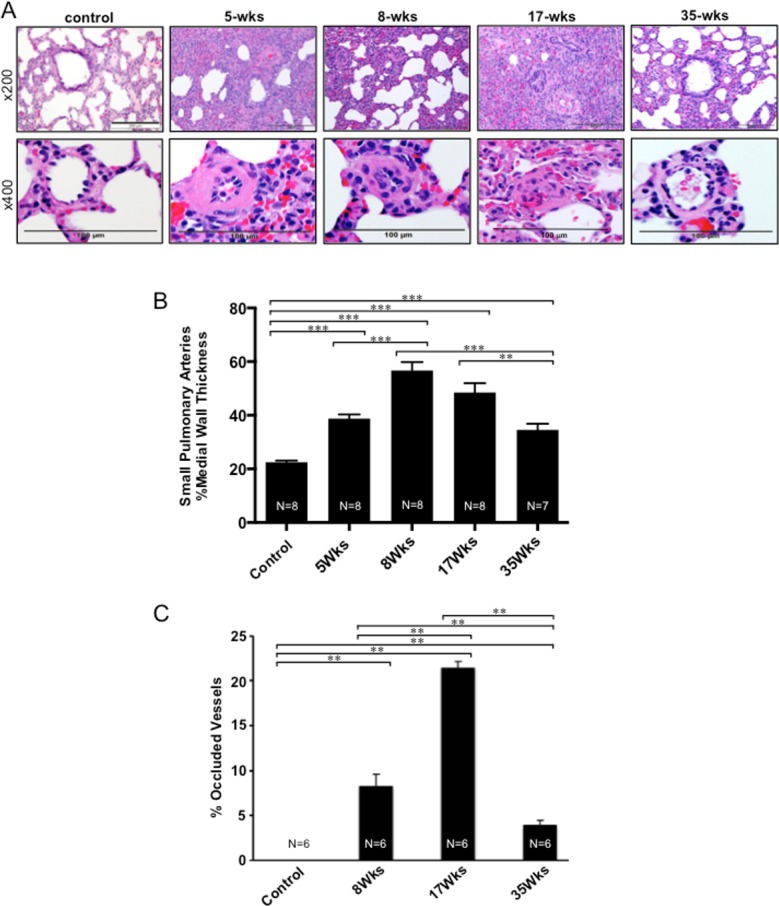
Pulmonary vascular remodeling.SU5416-injected rats were subjected to 3 weeks in hypoxia and then maintained in normoxia for 2, 5, 14 or 32 weeks (5-, 8-, 17- and 35-wks time points, respectively). (A) Representative lung H&E stain results at x200 and x400 magnifications. (B) Means ± SEM of % pulmonary arterial wall thickness. (C) Means ± SEM of % of completely occluded pulmonary arterial vessels (30–100 μm diameter). **Significantly different from each other at P < 0.01. ***Significantly different from each other at P < 0.001.